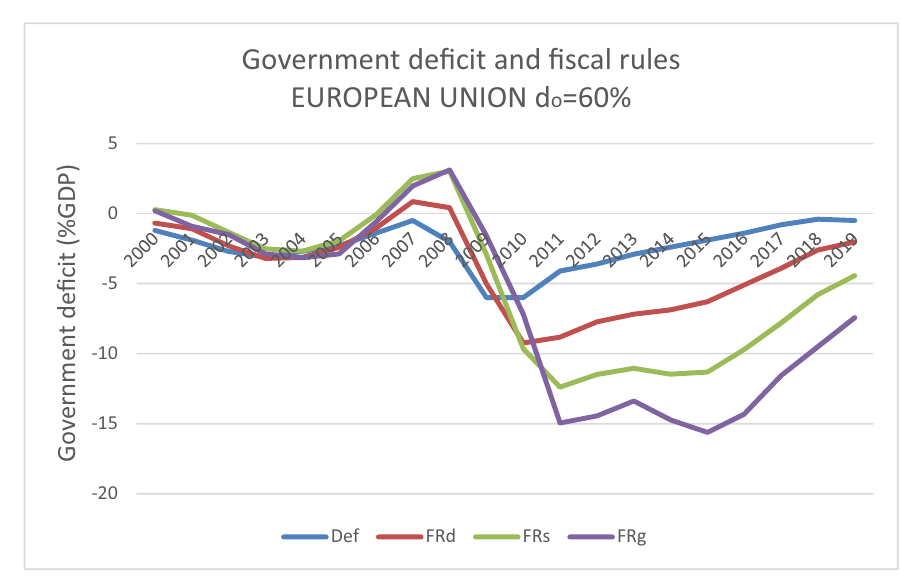
Figure 2.1: EU - 27 countries government de fi cit ( Source: Own elaboration from data on Table 2 )